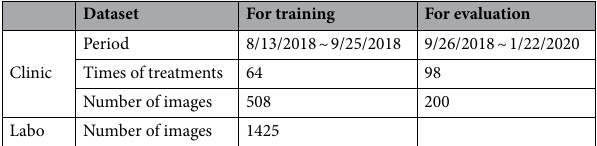
Table 1. Number of images in the dataset used for training and